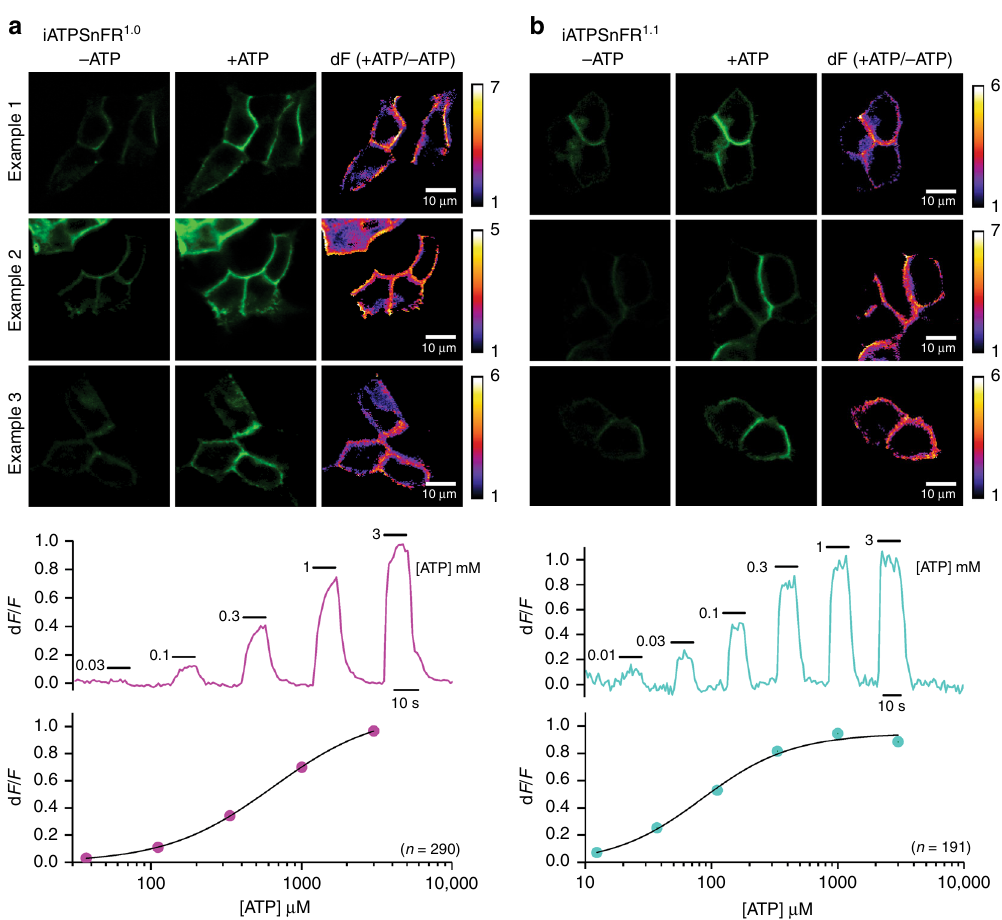
Fig. 2 Representative images and traces for responses measured with cell surface iATPSnFRs. a The upper panels show three examples of ATP responses for HEK293 cells expressing iATPSnFR 1.0 . The lower panels show representative traces and an average dose – response curve from 290 cells. b As in ( a ), but for iATPSnFR 1.1 . The dose – response curve represents an average from 191 cells. In the dose – response curves, the error bars represent the s.e.m. and in some cases are smaller than the symbols used for the mean. n numbers are provided in the fi gure panels and refer to the number of